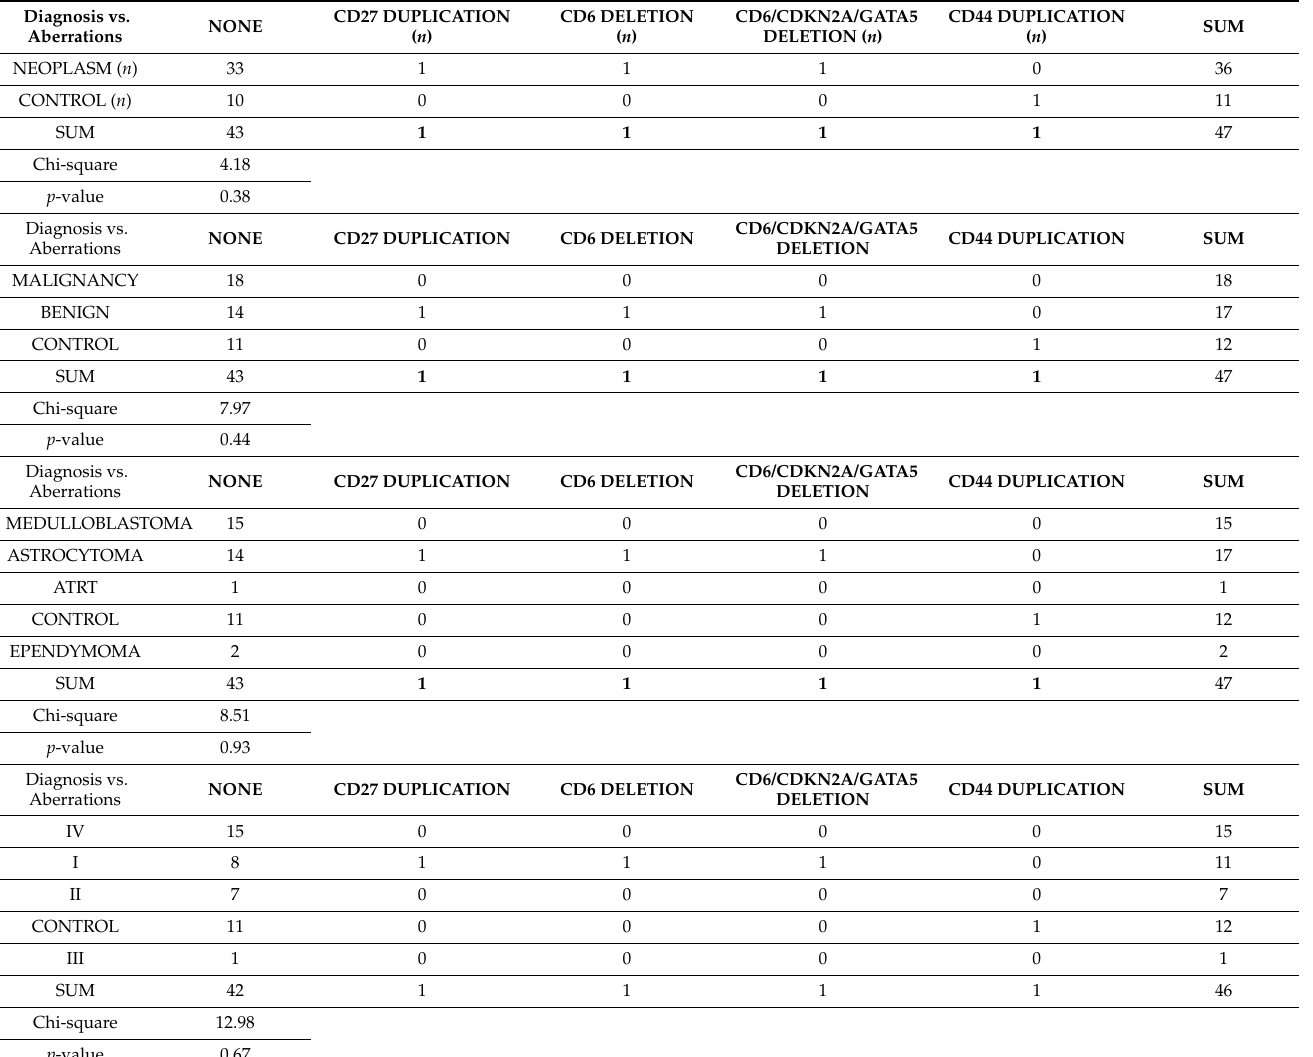
Table 4. Relations of copy number variations (CNV) with respect to sampling. The data represent the number ( n ) of samples found with CNV in each subcategory (CNVs separated with ‘/’ imply the simultaneous presence of those). In particular, we have investigated the relation of gene aberrations with respect to diagnosis and tumor grading. The table depicts the number of samples found to manifest a gene aberration with respect to their diagnosis, i.e., between (a) neoplasms and controls; (b) malignant, benign, and control tissues; (c) medulloblastoma, astrocytoma, ATRT, ependymoma, and controls; and (d) tumor